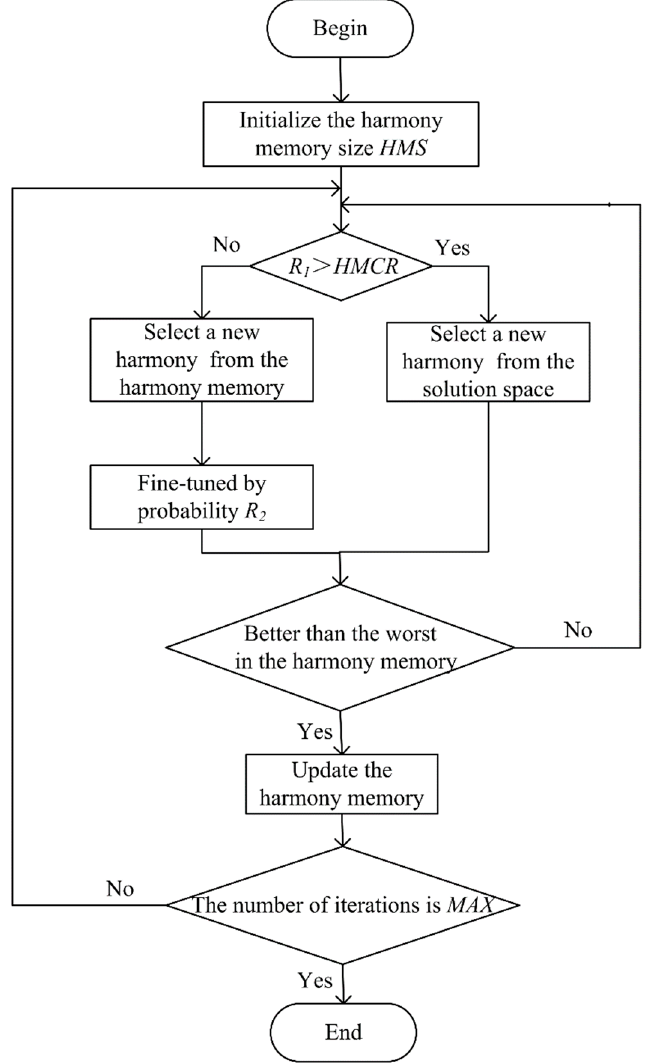
Figure 4. The flow chart of harmony search optimizer (HSO) algorithm.